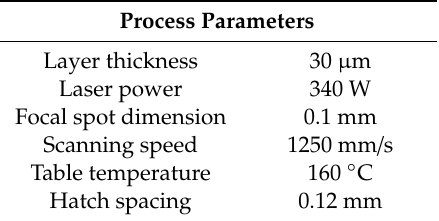
Table 2. Process parameters employed for all samples.